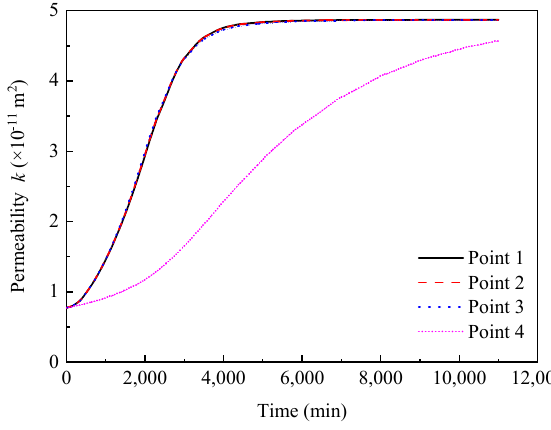
Figure 16. Evolution curves of permeability in saturated zone of railway subgrade.